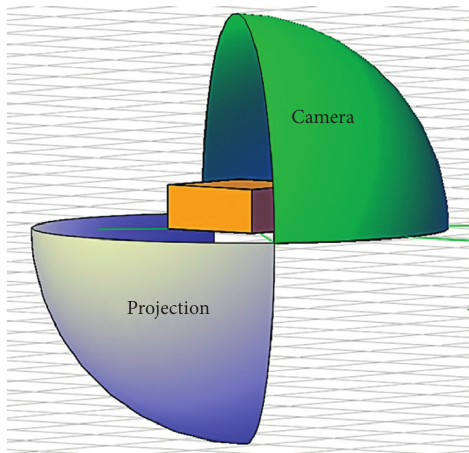
Figure 1: Image acquisition method.